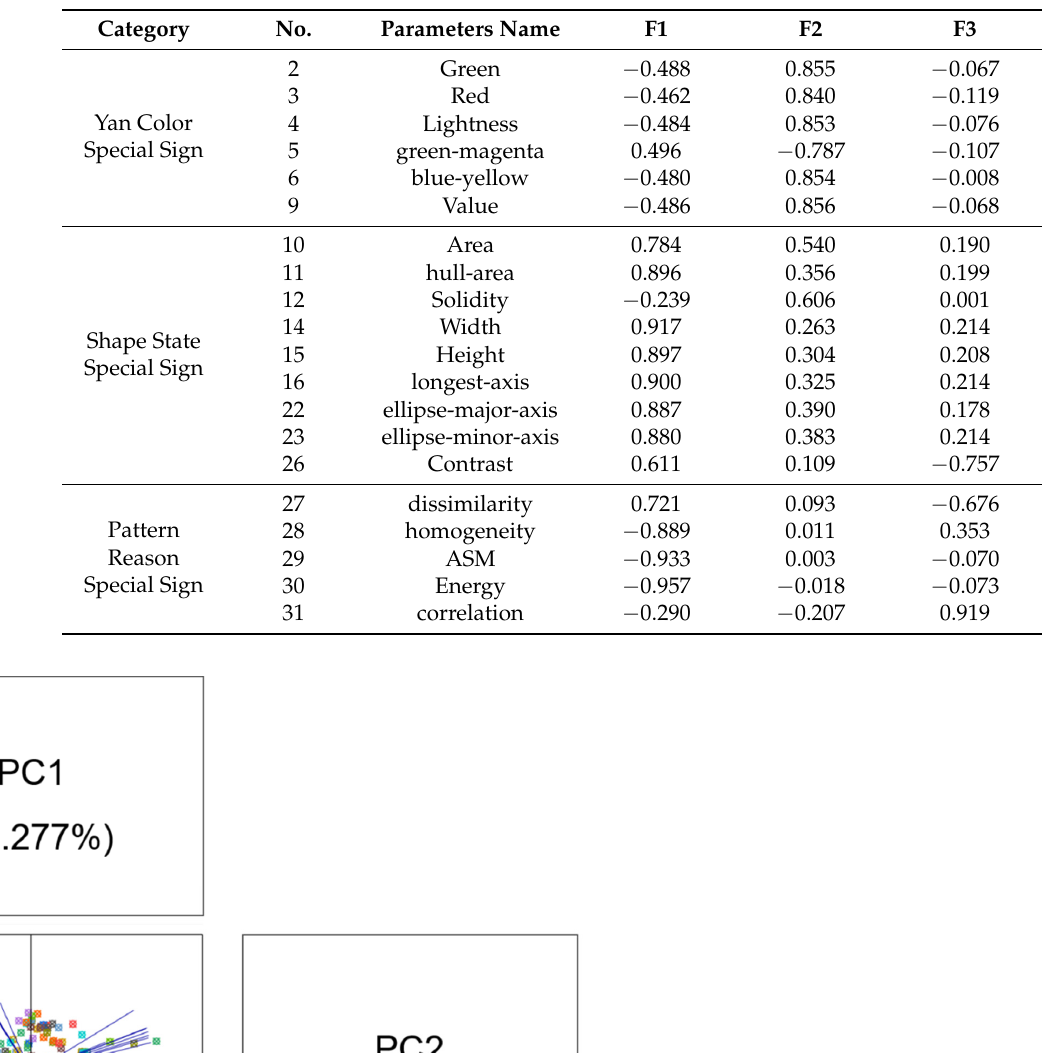
Table 2. Factors of principal component analysis of phenotypic feature parameters.